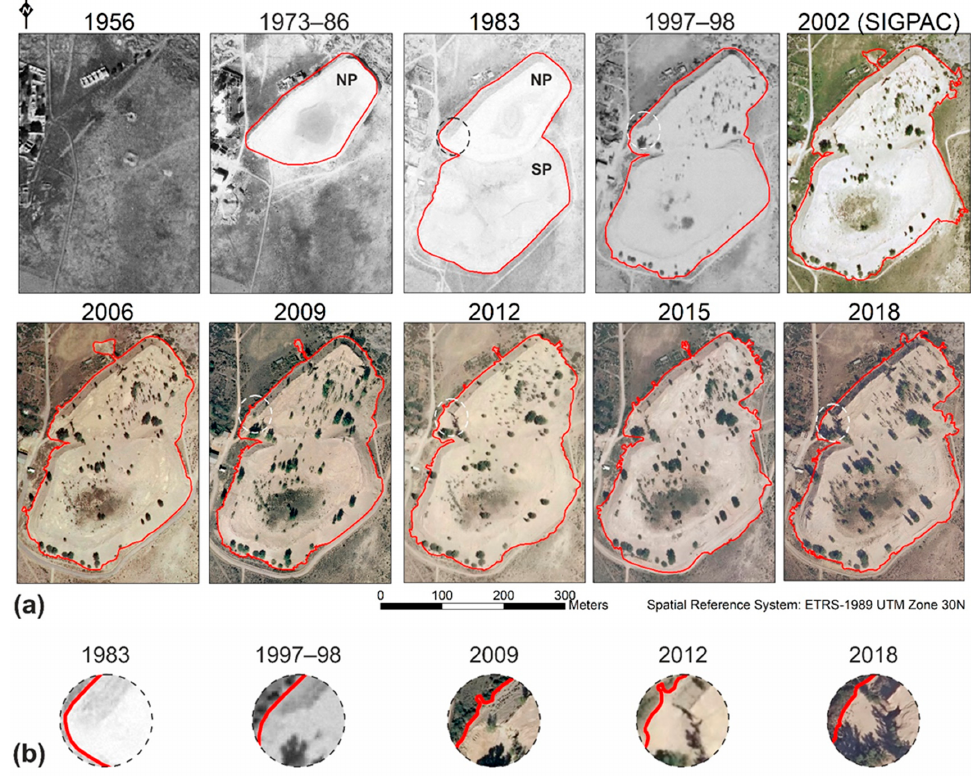
Figure 5. ( a ) Time evolution of the mining ponds of San Carlos. NP, north pond; SP, south pond; red lines, sludge contours. ( b ) Details of the south–west corner of the north pond; dashed circles in ( a ) = where tailings were extracted in a quarry.